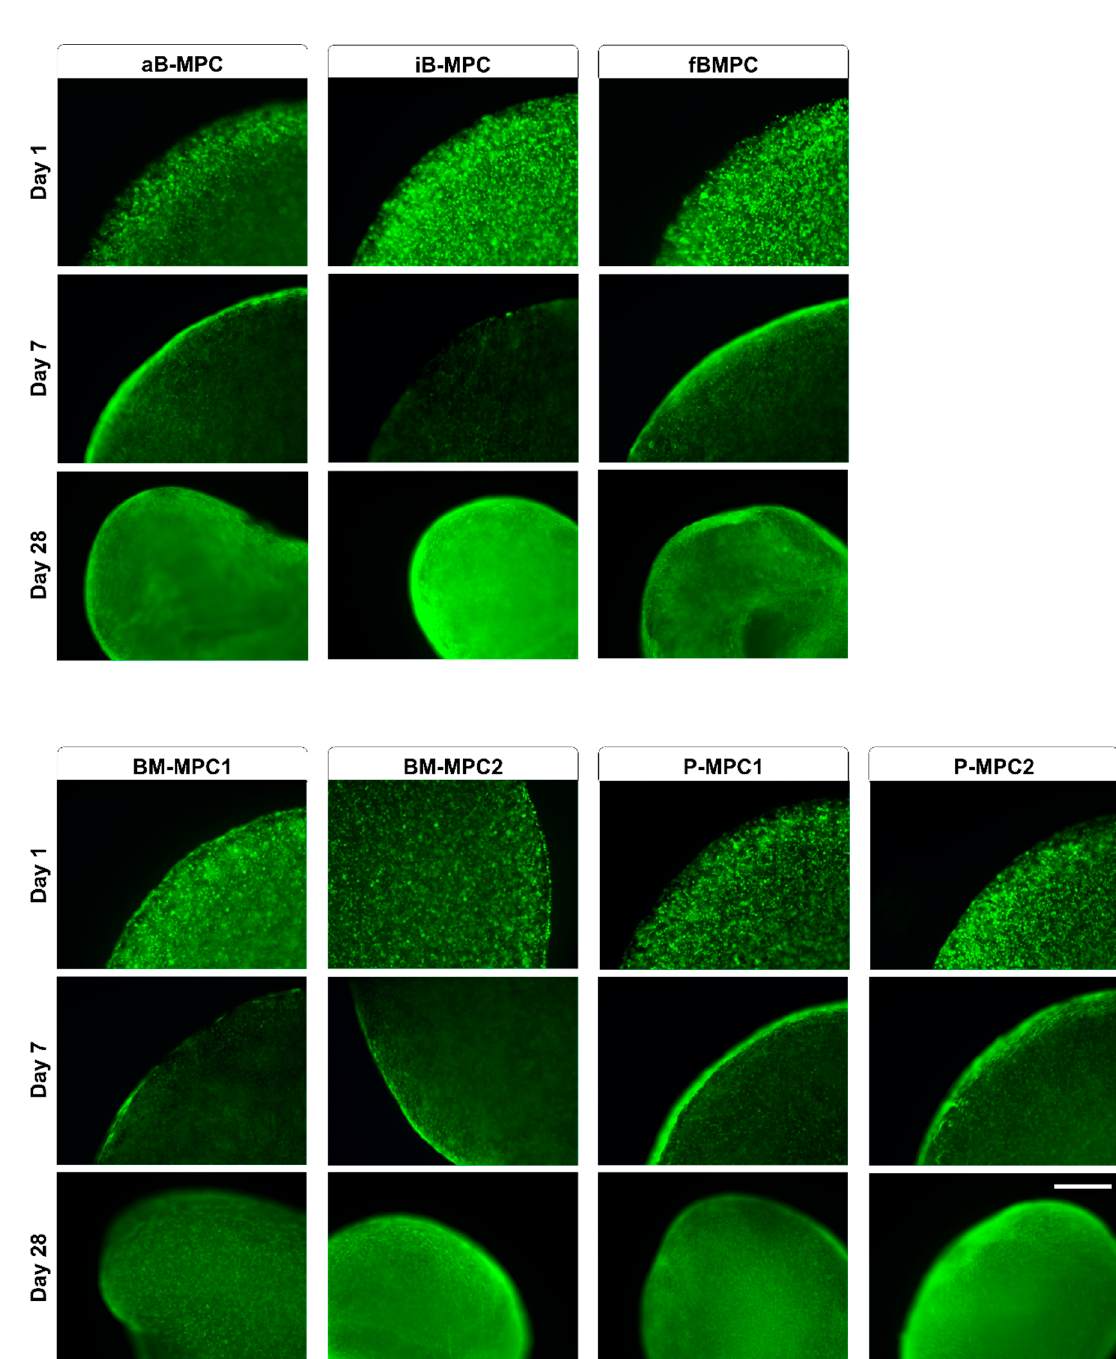
Figure A1. Viability of bioprints. Fluorescence microscopy images of constructs stained with PI/FDA showing living cells in green and dead cells in red on days 1, 7, and 28. Scale bar = 500 µm.